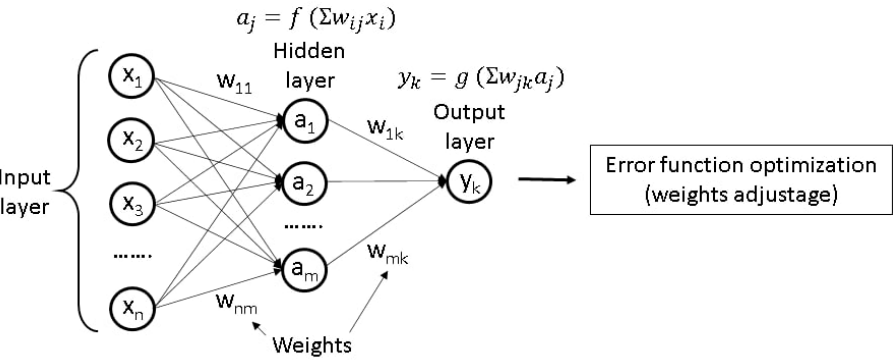
Figure 2. The scheme of a multilayer perceptron (a primitive model of ANN). Here, w ij and w jk are the connection weights, f and g are the activation functions. the connection weights, f and g are the activation